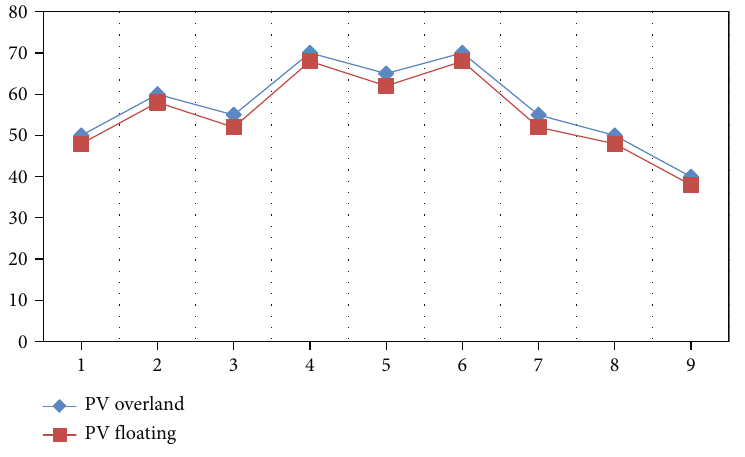
Figure 9: Module temperature variation.